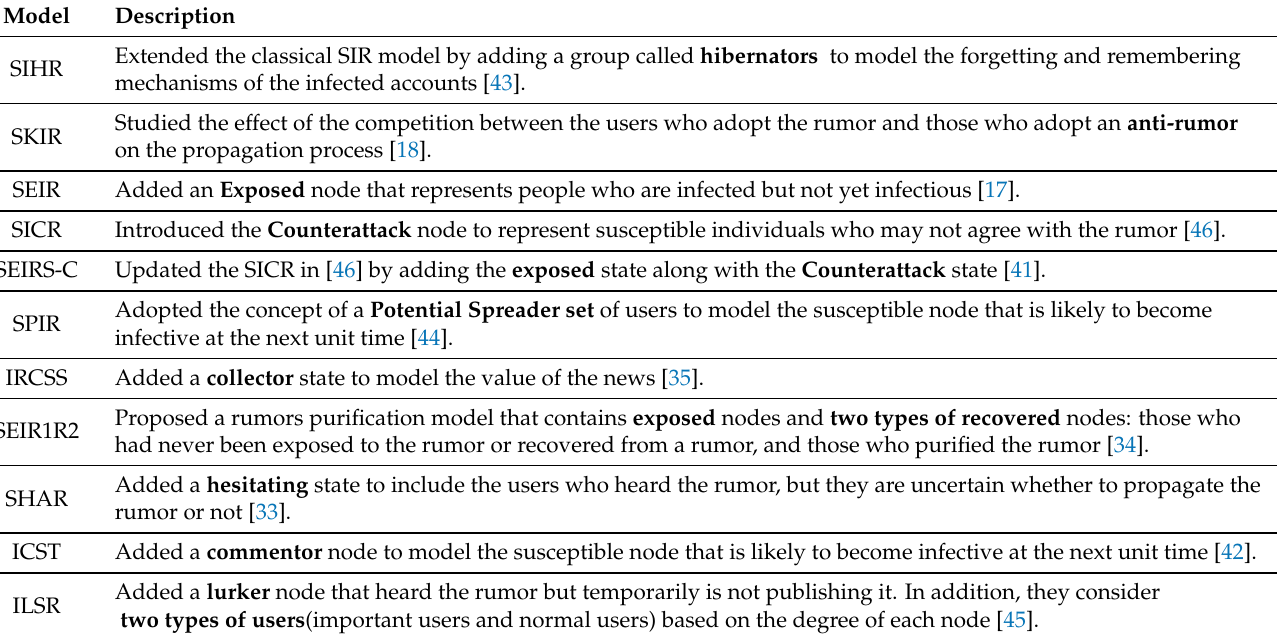
Table 1. Different modifications to the classical SIR model by adding new node